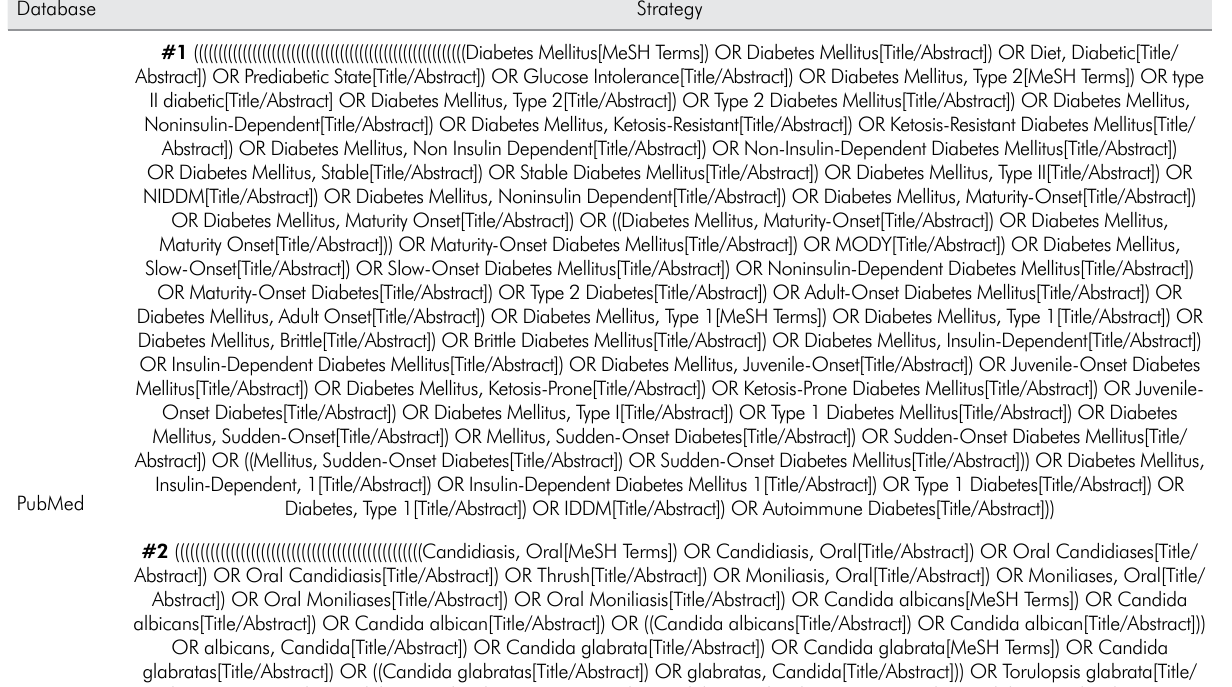
Table 1. Search strategy based on the databases assessed in the present